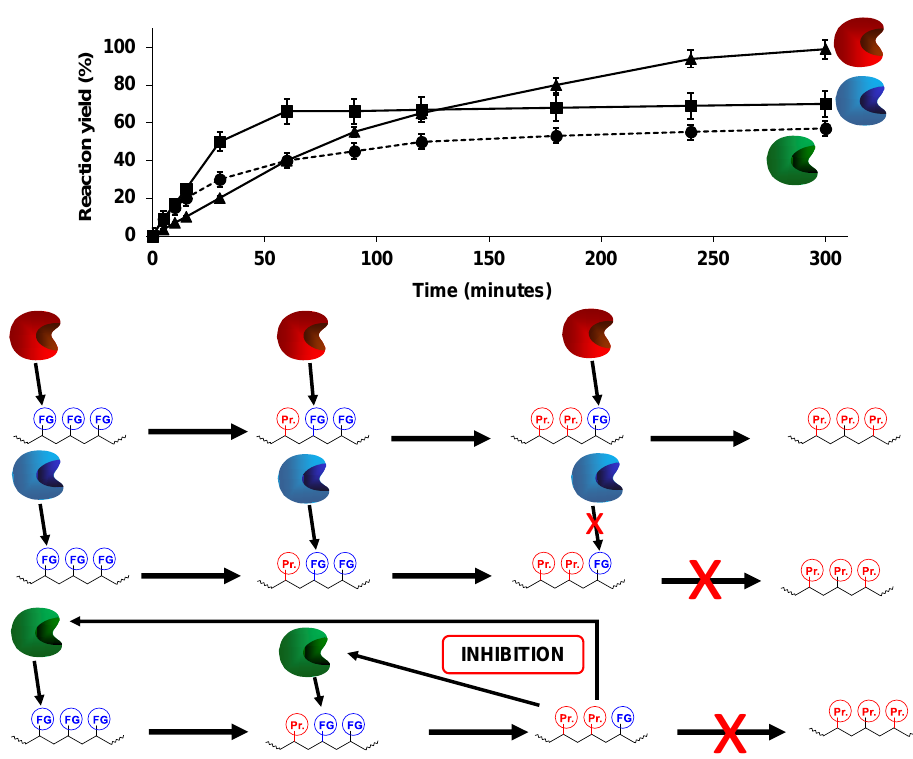
Figure 6. Effect of enzyme specificity and product inhibition in the reaction courses of modification multifunctional substrates. The figure shows one very active enzyme that cannot hydrolyze the last intermediate product, other that is less active but recognize all intermediate products and a last enzyme that not only cannot modify the last intermediate product, but that is also inhibited by it.